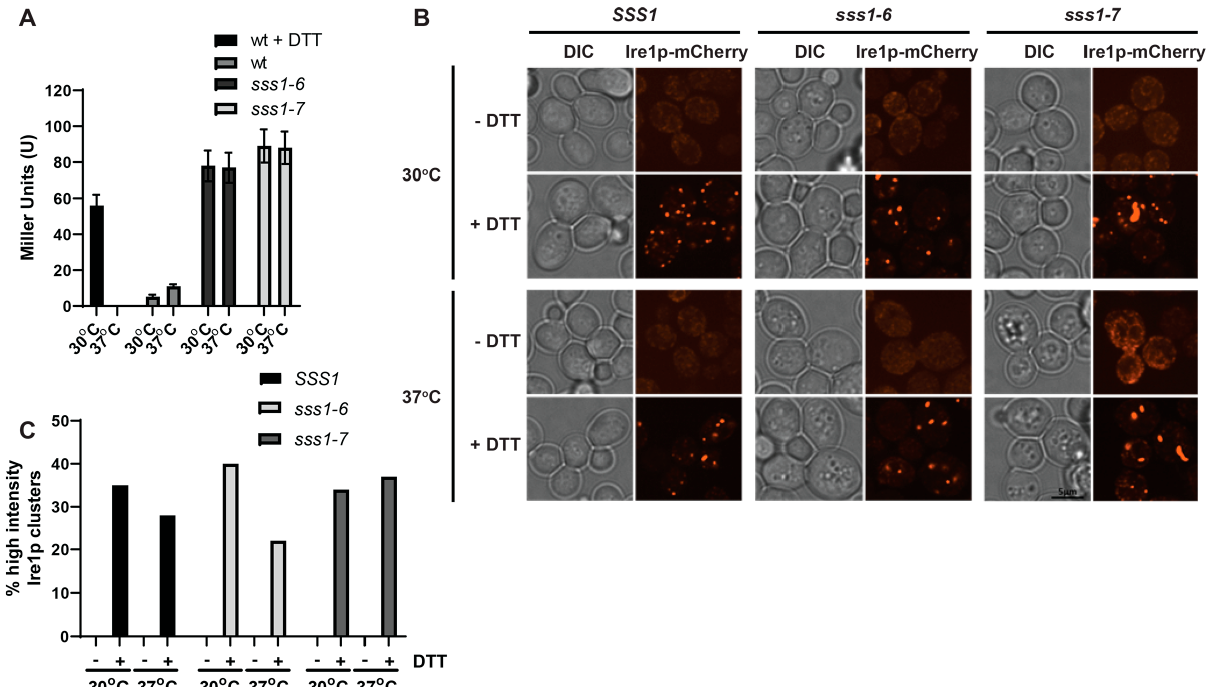
Figure 6. The UPR can be active despite the absence of Ire1 cluster formation. ( A ) Fluorescence microscopy images of wt, sss1-6 and sss1-7 cells expressing Ire1-mCherry. Cells were cultured at 30 °C and 37 °C for 2 h, followed by treatment with ±10 mM DTT. ( B ) Cell counts determining the proportions of cells containing high-intensity Ire1-mCherry clusters (taken from microscopy images described above). At least 150 cells were counted for each condition. ( C ) Wt, sss1-6 and sss1-7 cells transformed with pJT30 (UPRE-LacZ) were grown in –Ura selective medium and β -Galactosidase activity determined. As a positive control, wildtype cells were treated with 5 mM DTT for 2 h.